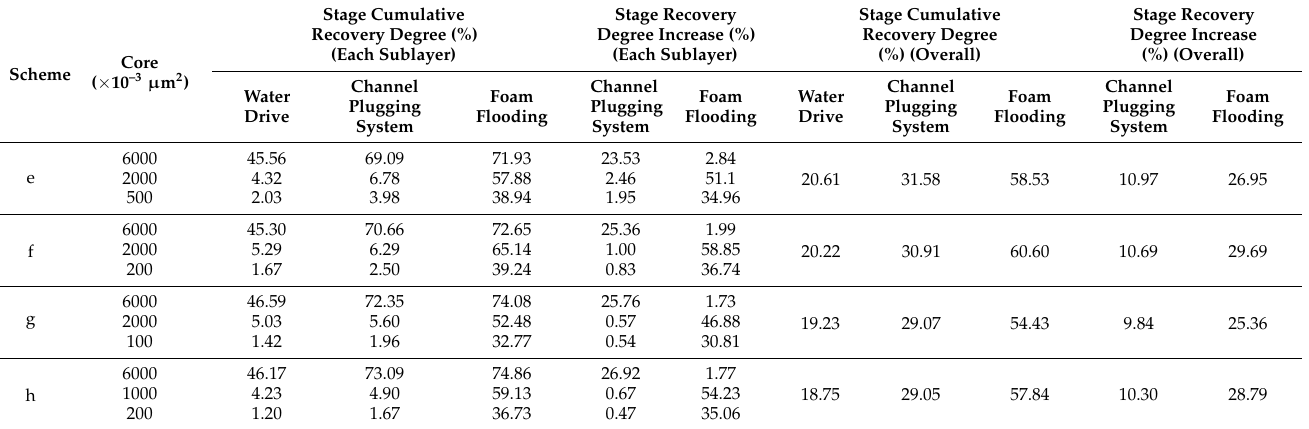
Table 7. Comparison of oil drive effect of inter-layer inhomogeneous model with different permeabil- ity